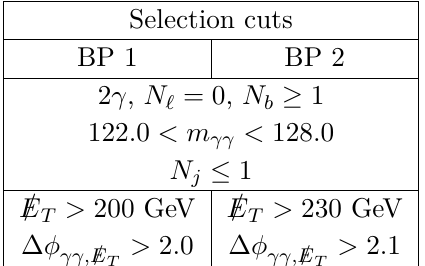
channel for the cut-based analysis. T